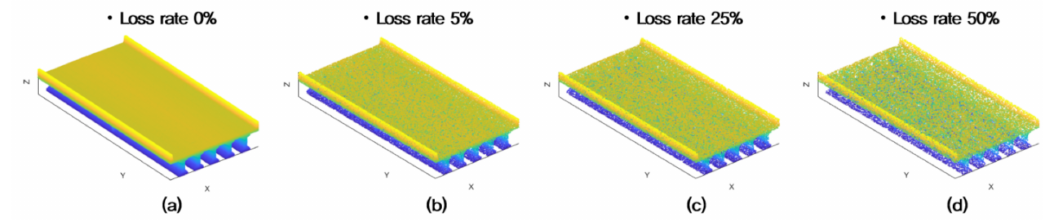
Figure 17. A BIM model-based validation dataset ( a ) w / o data loss, ( b ) w / 5% data loss, ( c ) w / 25% data loss, and ( d ) w / 50% data loss.